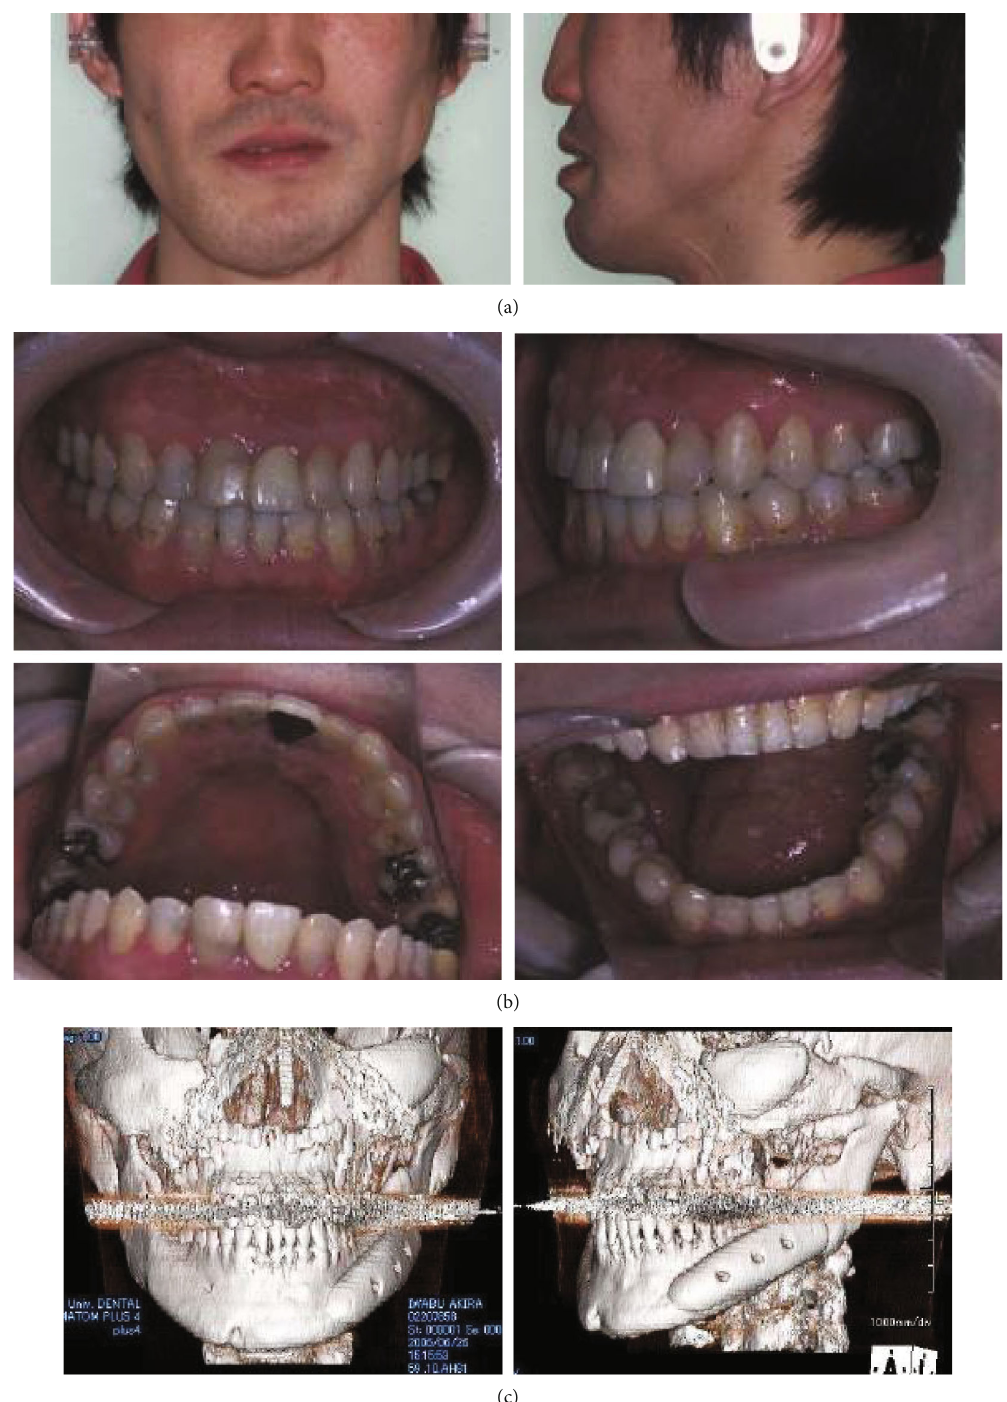
Figure 6: Facial (a) and intraoral photographs (b) and CT images after postoperative orthodontic treatment